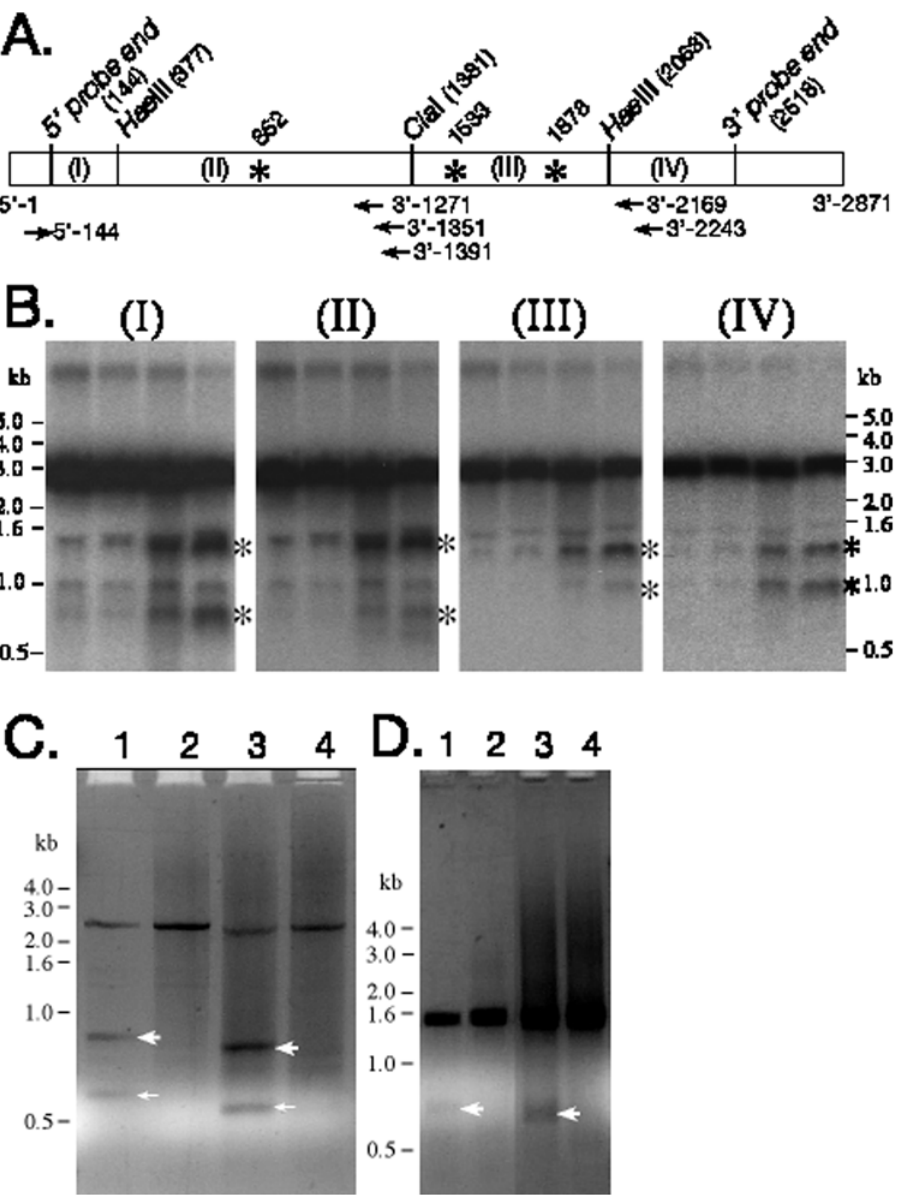
Figure 3. Determining the sites of LSU rRNA cleavage. (A) A map of D. discoideum mitochondrial LSU rRNA showing the position of restriction sites and oligonucleotide primers (arrows) used to define the cleavage sites (asterisks). LSU rRNA was amplified by RT-PCR and digested with Cla I and Hae III into four segments (I, II, III and IV). (B) The fragments in A were used individually as probes and hybridized to northern blots of total RNA extracts from D. discoideum infections. Labeled bands were used to infer the approximate cleavage sites on the rRNA. For example, the major cleavage site is , 1.5 kb, and one minor cleavage site is 0.8 kb, from the 5 9 end of the rRNA (panels I and II, asterisks) whereas the major cleavage sites is , 1.3 kb and the other minor cleavage site is , 1.0 kb from the 3 9 -end of the rRNA (panels III and IV, asterisks). (C) The 5 9 RACE products from the cleaved D. discoideum mitochondrial LSU rRNA. Total RNA samples from D. discoideum infected by virulent strain JR32 (lanes 1 and 3) or infected by avirulent strain icmT (lanes 2 and 4) were used in RACE reactions with PCR primers 3 9 -2243 (lanes 1 and 2), or 3 9 -2169 (lanes 3 and 4), and the RACE AAP primer (see Materials and Methods). The products resulting from the major cleavage site at base 1533 (thick arrows) and the minor cleavage site at base 1878 (thin arrows) are evident on the ethidium bromide stained agarose gel (negative image). The four smaller bands were cloned and sequenced to determine the cleavage sites. (D) Determination of the 5 9 side minor cleavage site by RACE. Total RNA from 20-hour virulent (JR32) infection (lane 1) and 20-hour avirulent icmT infection (lane 2) were used in 5 9 -RACE reactions with primers 3 9 -1351 and the RACE AAP primer. Nested PCR reactions using the products shown in lanes 1 and 2 as substrates, with primer 3 9 -1271 and the RACE AUAP primer (lanes 3 and 4, respectively). The lower bands in lanes 1 and 3 (arrows) were cloned and sequenced to determine the minor cleavage site at base We attempted to identify the L. pneumophila protein responsible domains [43]. The best candidate that we identified is a T2 RNase for the rRNA cleavage using a candidate gene approach. We family enzyme that contains additional amino acid sequences that examined all of the predicted protein products of the L. pneumophila are not found in other ‘‘housekeeping’’ ribonucleases. An L. genome for those containing any known RNase or ricin/sarcin